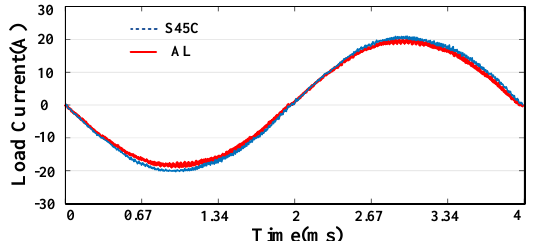
Figure 13. The comparision of current